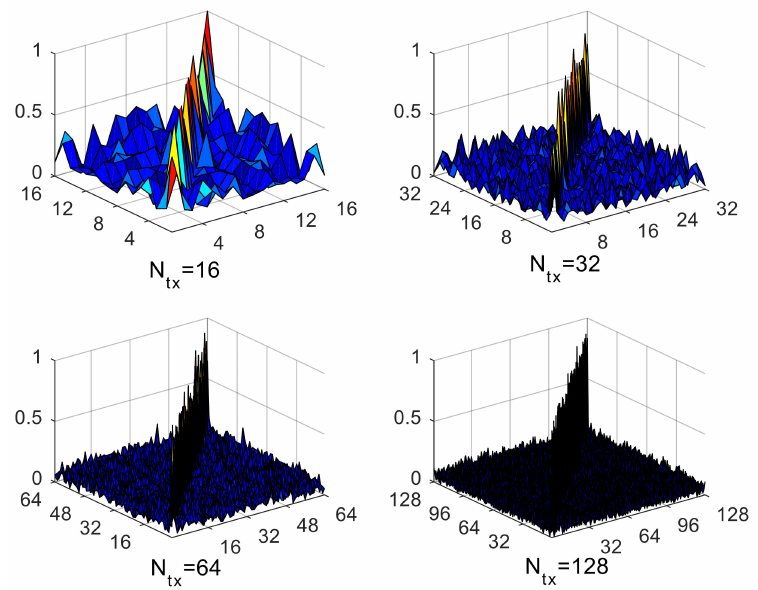
Figure 4. Power distribution of channel correlation